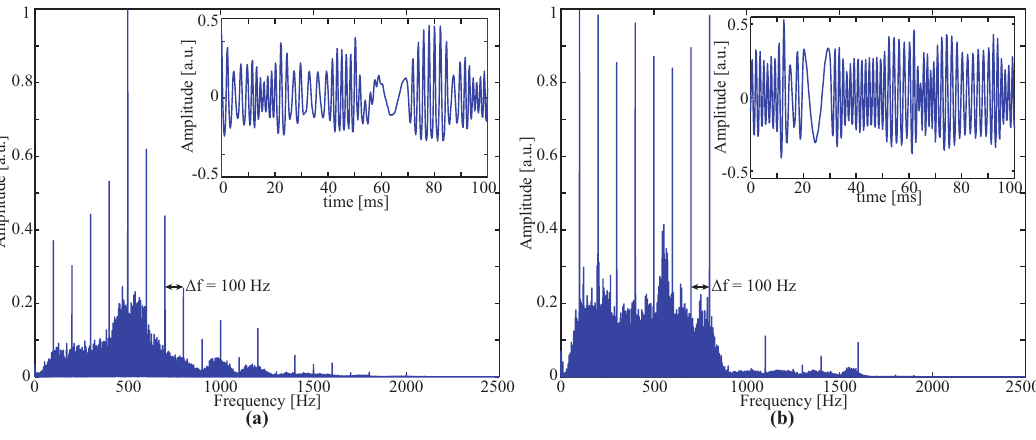
Figure 7. Spectra and temporal responses for 8-FSK: ( a ) uncompensated and ( b ) pre-emphasis